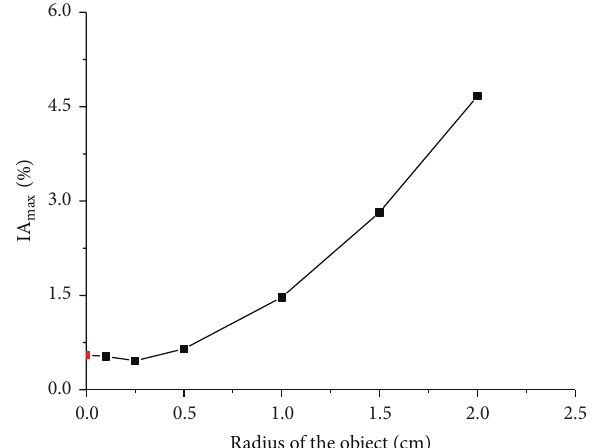
Figure 16: IA max of EIT data from the two hemispheres of the model with and without an ischemic lesion. Black points represent IA max with a simulated ischemic stroke lesion, while the red point represents IA max without a simulated lesion.